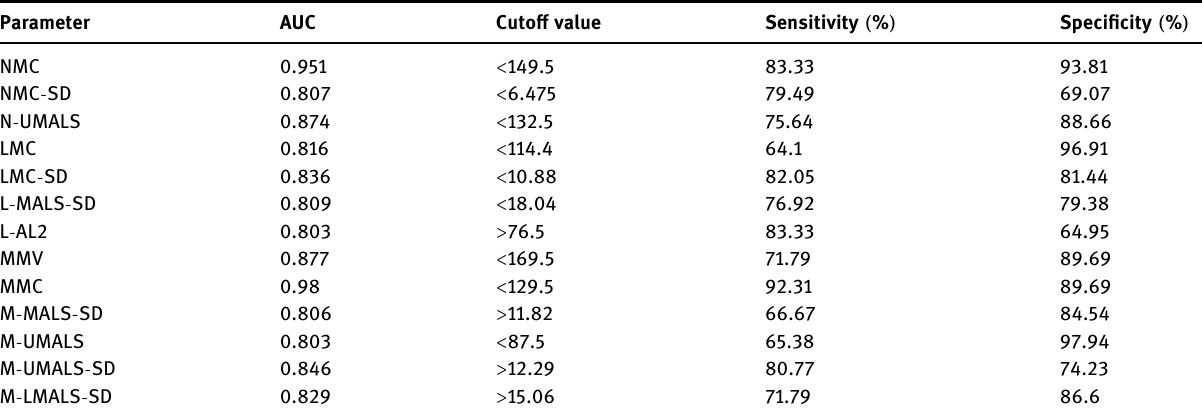
Table A2: Sensitivity and speci fi city at the designated cut - o ff values of parameters for di ff erentiating active tuberculosis from community - acquired